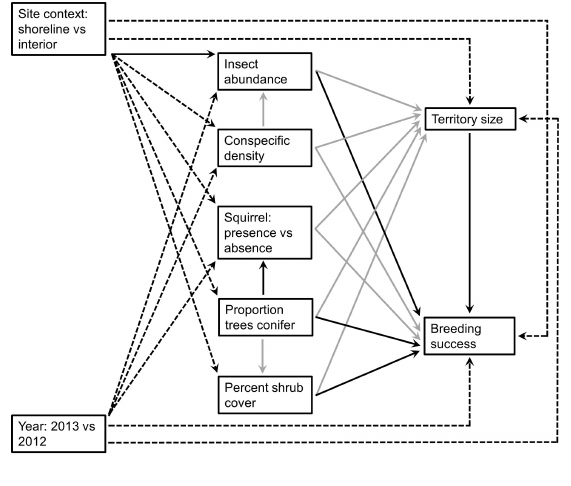
Fig. 1 . Global path model depicting direct and indirect relationships between variables hypothesized to effect territory size and breeding success for Canada Warblers ( Cardellina canadensis ) in western Canada. Solid black arrows represent hypothesized positive effects, grey arrows represent hypothesized negative effects, and hatched black arrows represent paths for which the direction of effect is unknown, i.e., a positive or negative effect could be reasonably